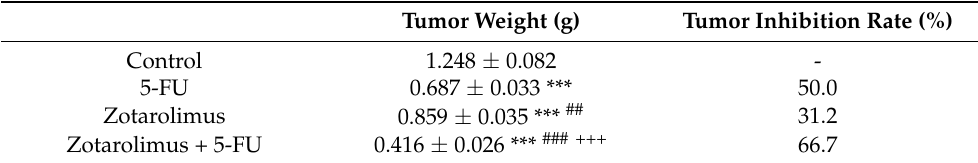
Table 1. Weight of the tumors from BALB/cByJNarl mice after